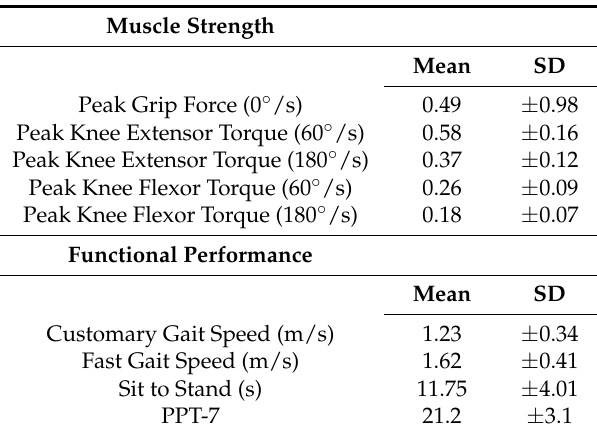
Table 2. Physical performance